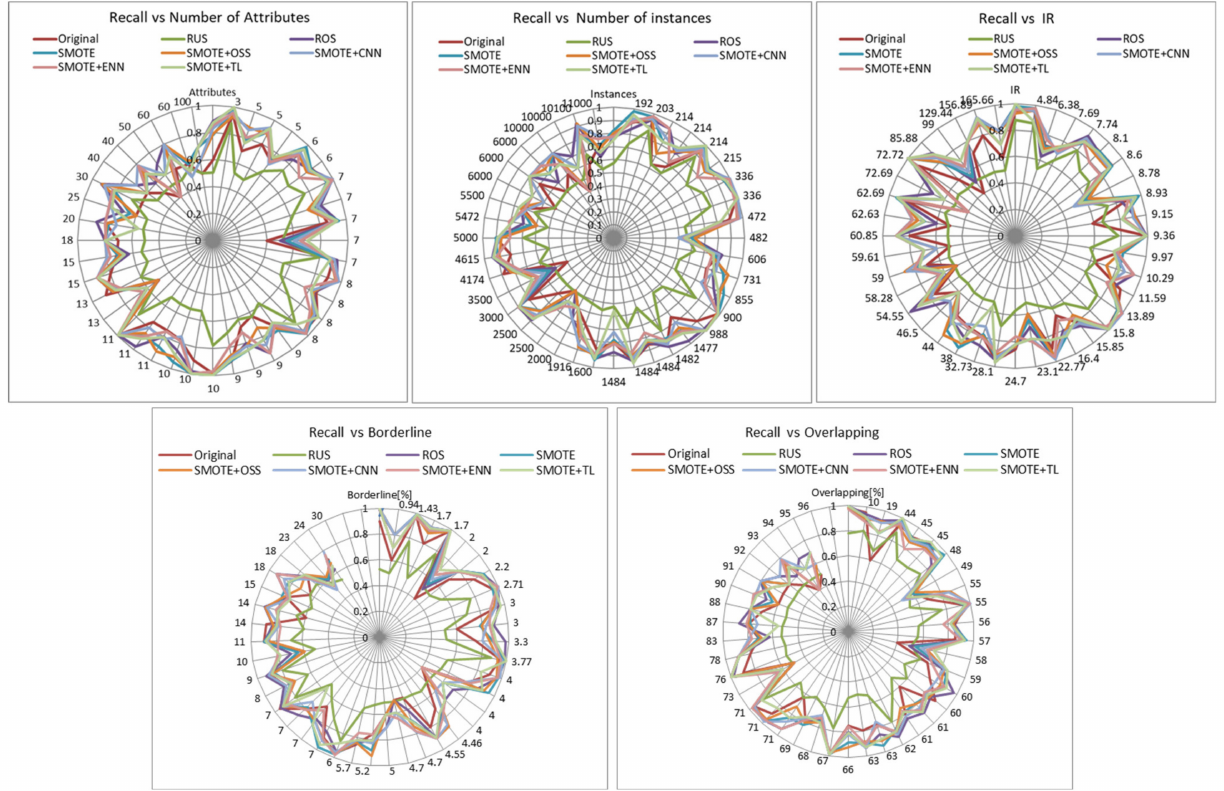
Figure 4. Influence of dataset characteristics on recall for all resampling